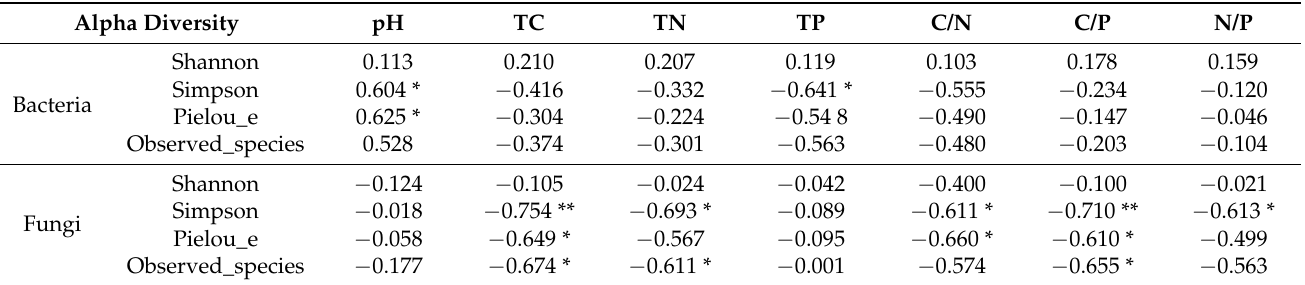
Table 4. Relationship between soil physicochemical properties and stoichiometry and alpha diversity of soil microbial community.